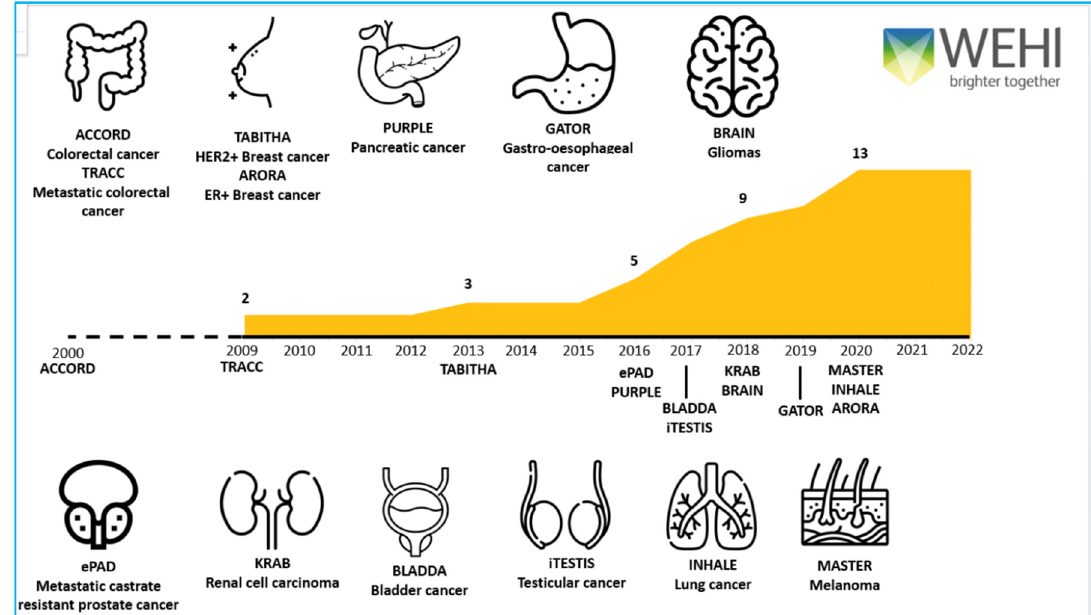
Figure 1. Solid tumour registries by date of protocol